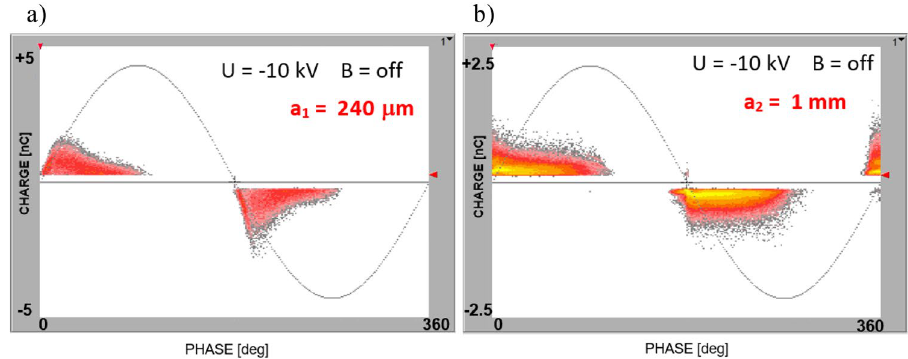
Figure 9. PD patterns recorded at 10 kV (B = off) for sample with embedded voids with thicknesses of ( a ) 240 μm and ( b ) 1 mm.